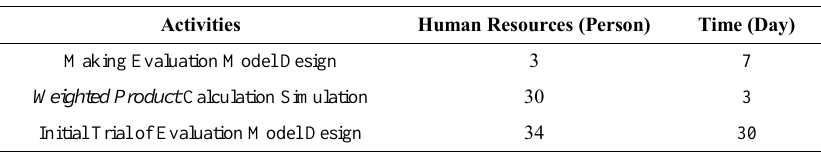
Table 6. Management of Human Resources and Time in Making the Evaluation Model Design and Simulation Time for